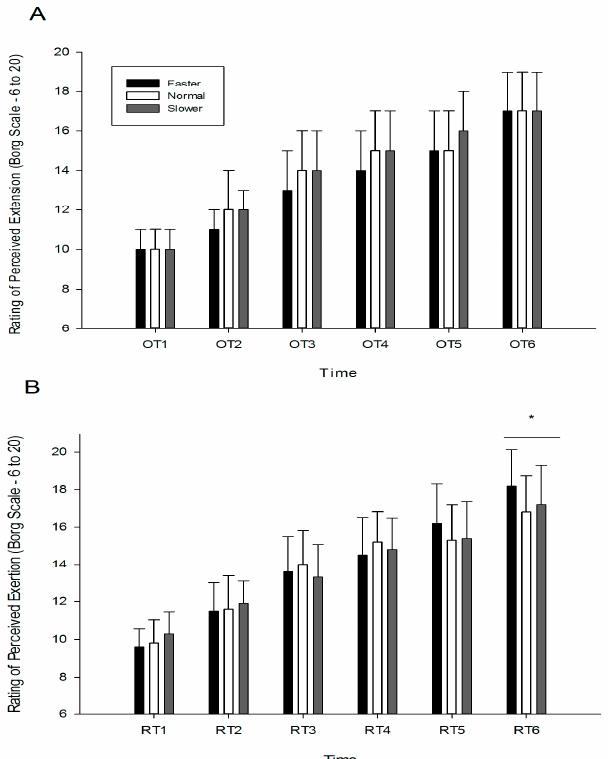
Figure 5. RPE (Borg scale 6 to 20) in the ( A ) observed time (OT) and ( B ) real time (RT) analysis. Mean ( ± SD) data for RPE for each condition with respect to ( A ) OT (every 10-min period of the observed time) and ( B ) RT (every 10-min period of the real time). Notes: * Significant differences between FC (18) and both NC (17) ( p = 0.030) and SC (17), p = 0.015.